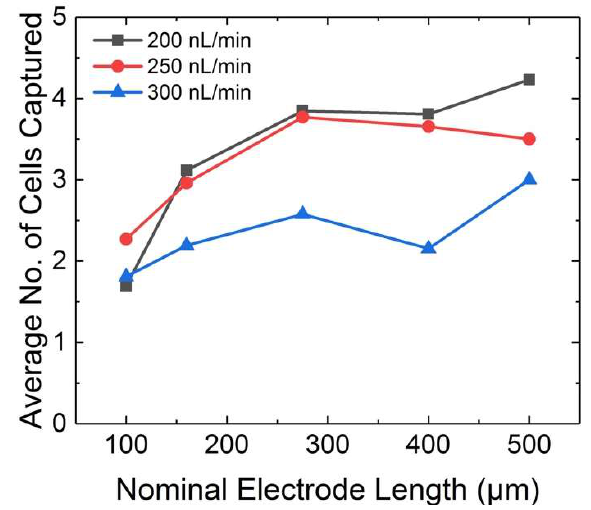
Figure 4. Plot of average cell cluster size at each BPE length (over two replicates) at ∆ U tot = 26 V pp (70 kHz) for three distinct flow rates: 200, 250, and 300 nL / min. Data was obtained at t = 5 min.